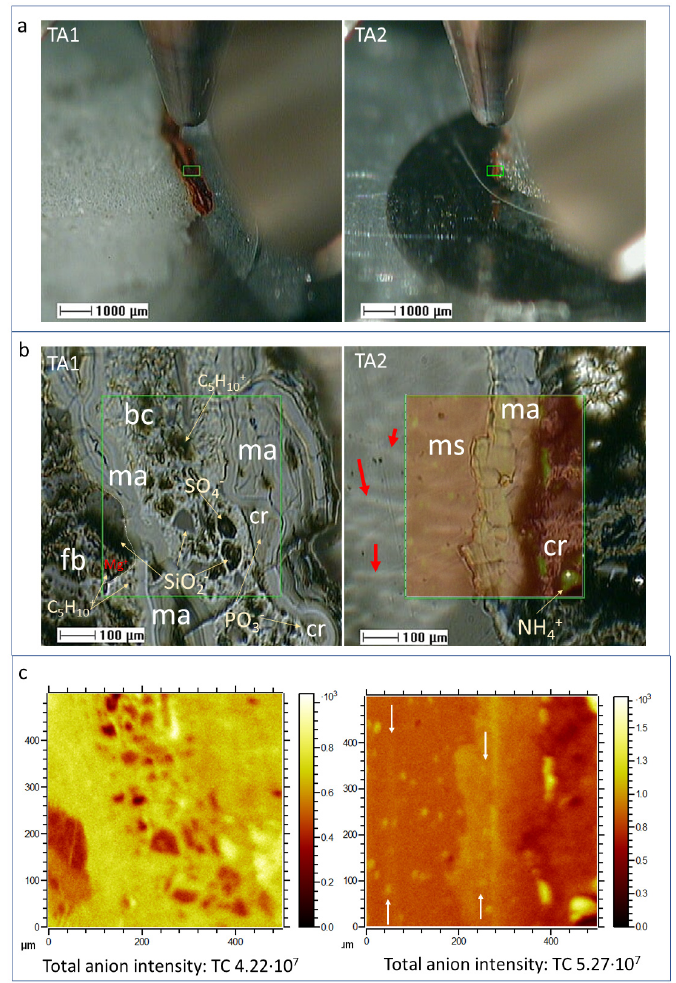
Figure 2. Different images of the target areas 1 and 2 (TA1, and TA2) in the sample BH8-24c showing the fabric and microstructure of the mineral deposits infilling the hydrothermal host rock. ( a ) Images taken by the ToF-SIMS visible camera where it is possible to appreciate the different ferruginous and sulfatic materials filling a crack in the Carboniferous basement. ( b ) Microimage obtained by the ToF-SIMS SEM probe showing the internal fabric and structure of sample BH8-24c in TA1 and TA2. They are composed by four different layered units including fibrous and cryptocrystalline (fb), microlaminated (ma), microbrecciated (mb), and glassy (ms), as well as a crenulated patchy unit (cr). Interestingly the glassy layer (ms) shows internally crossed by some filamentous microstructures (red arrows). ( c ) ToF-SIMS image displaying the total intensity counts that provide additional information of the sample microstructure in form of different sets of micronodular elements, fine laminas, and microstructure alignments (see white arrows).